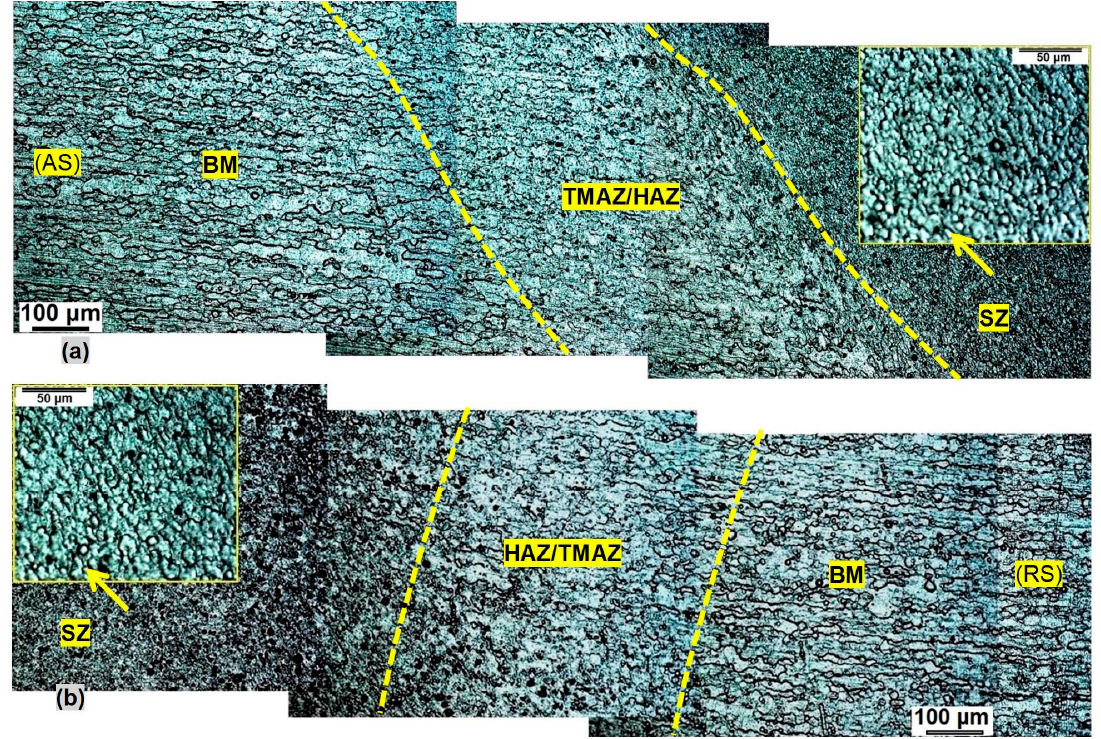
Figure 3. Photomontage of the microscopic features for the BFSW weld structure, near the AS and RS borders (etched by Reagent B). ( a ) transition region in AS border (regions 3 in Figure 2b), ( b ) transition region in RS border (regions 4 in Figure 2b).